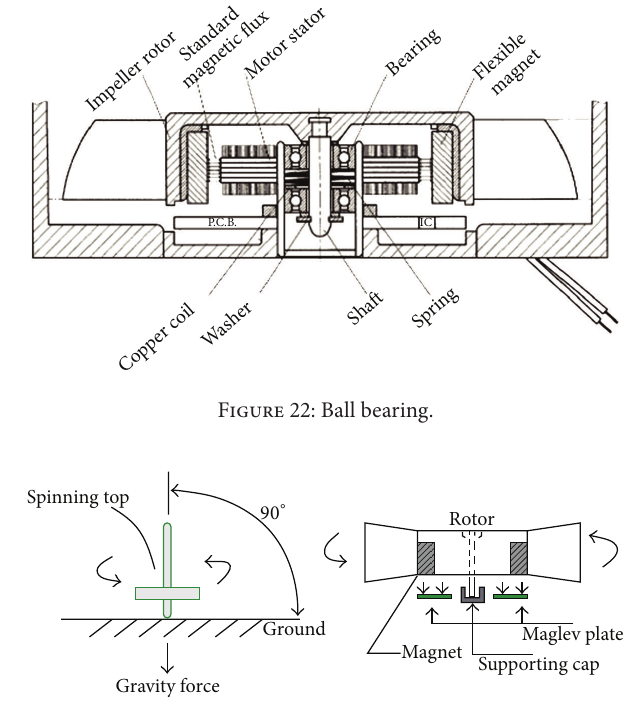
Figure 23: Performance of maglev fan system